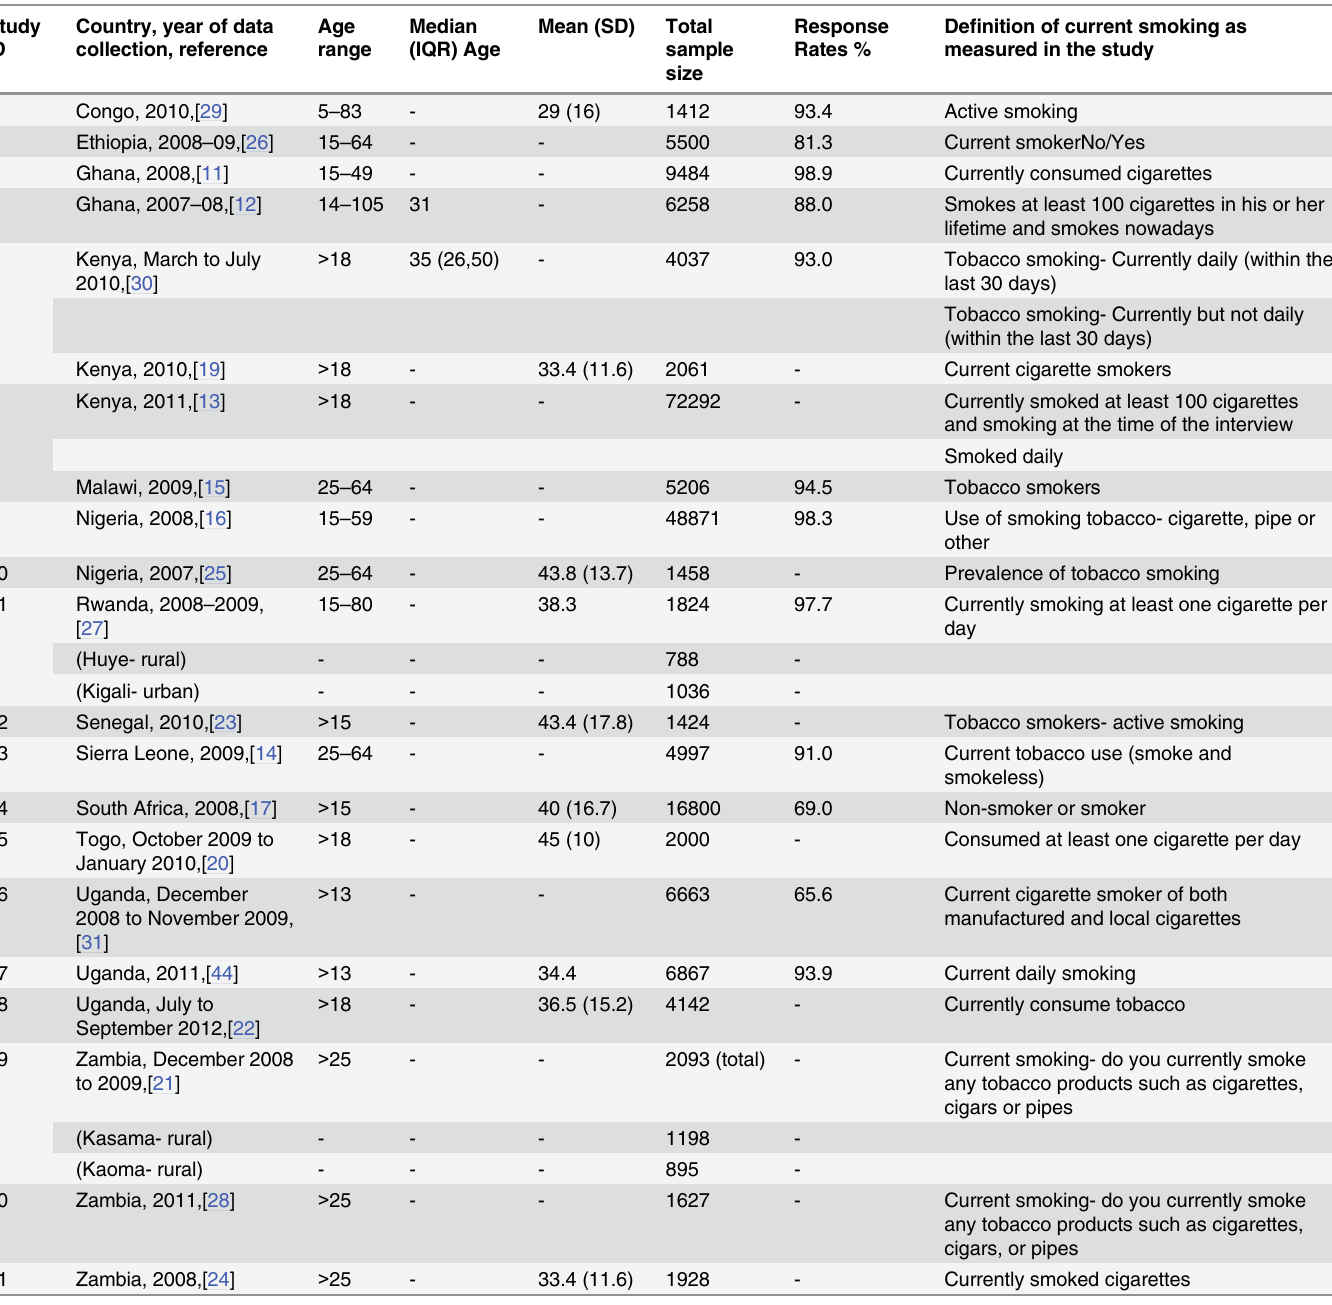
Table 1. Characteristics of study populations of included